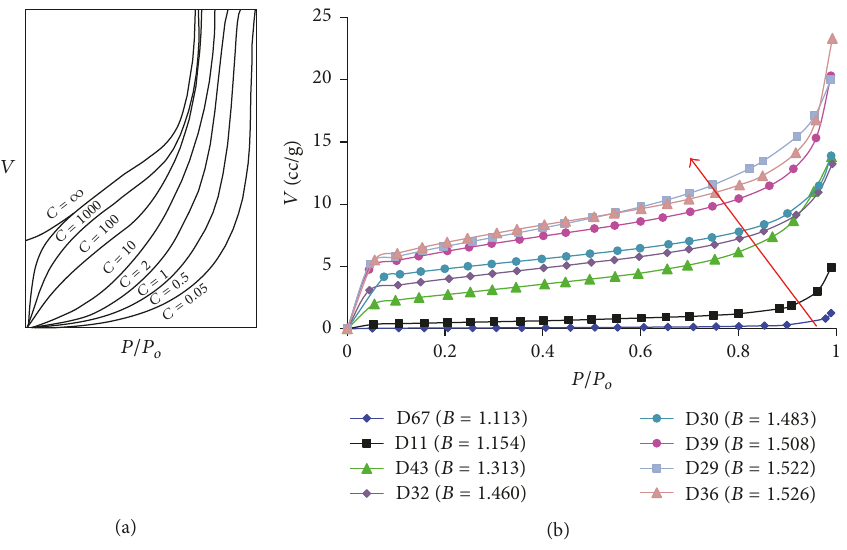
Figure 6: Change in shape of adsorption curve versus change in value of 𝐵